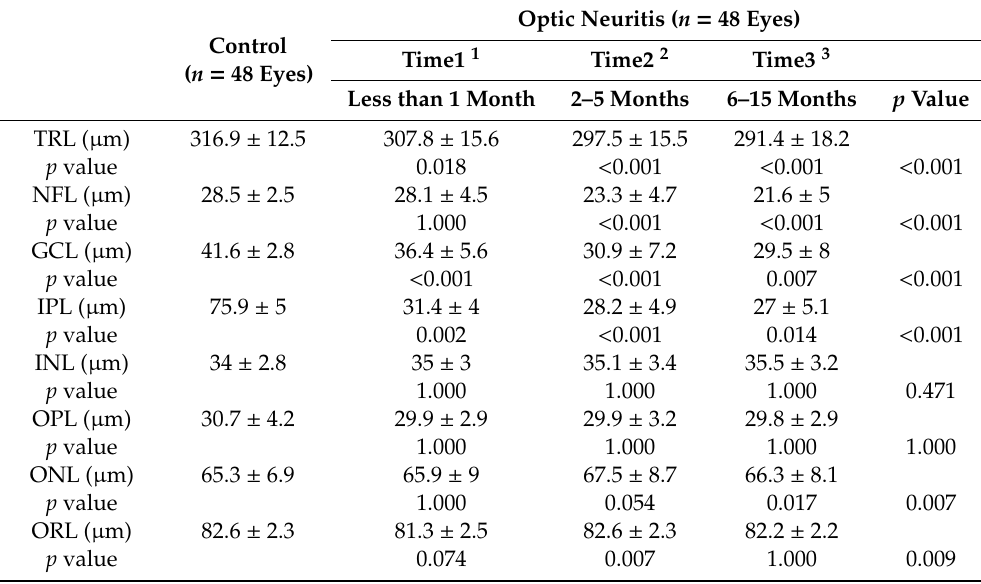
Table 2. Mean retinal layer thickness of optic neuritis eyes and healthy control eyes over